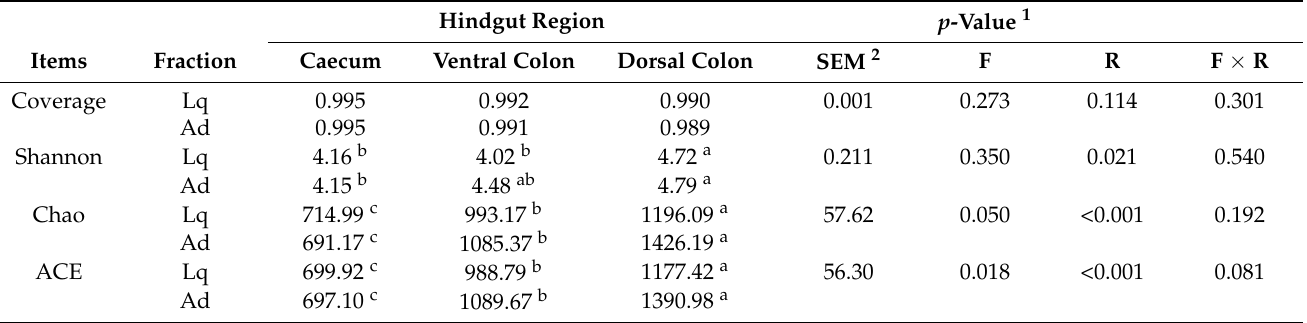
Table 2. Bacterial alpha diversity indices in the liquid (Lq) phase and adherent (Ad) fraction within donkey caeco-colic ecosystem. Hindgut Region p -Value 1